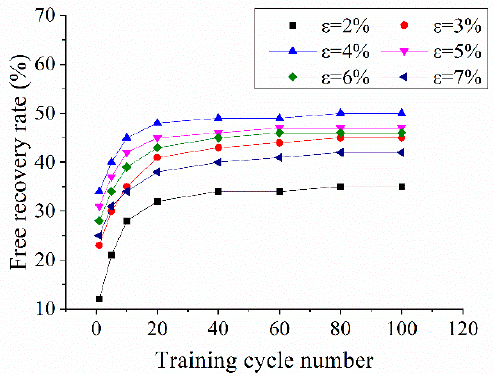
Figure 5. Two-way shape memory effects.